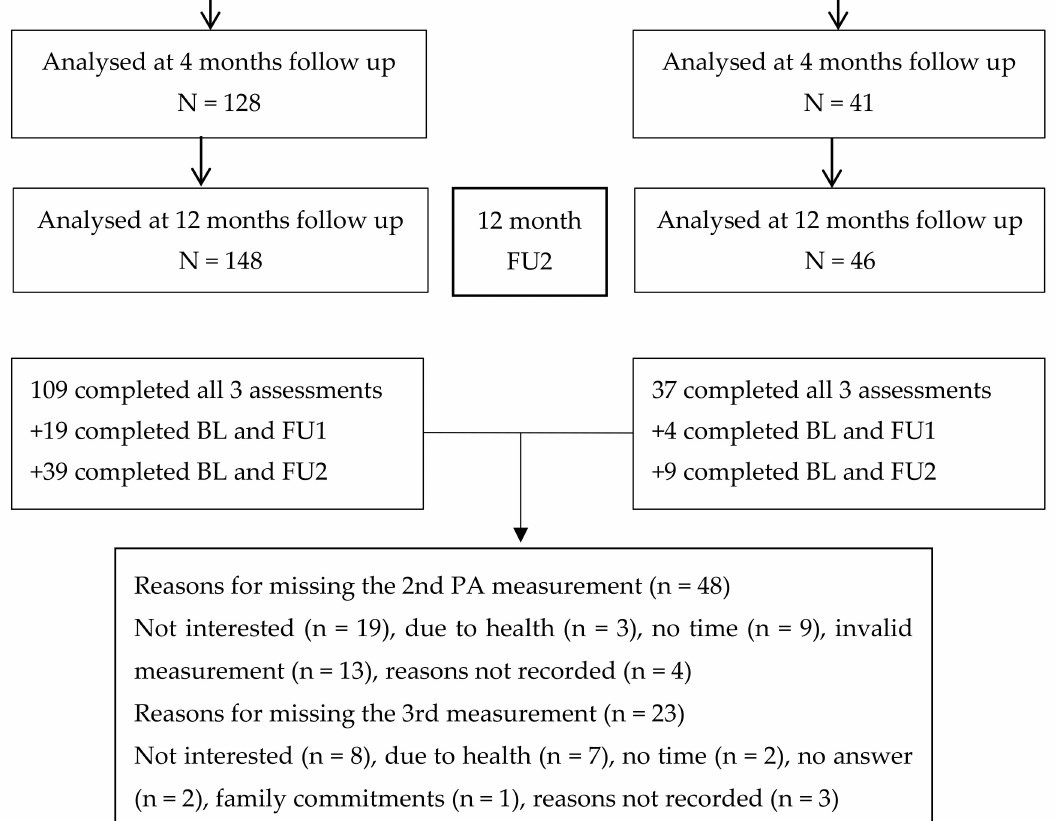
Figure 1. Recruitment and participation flow in the study (BL = baseline, FU = follow-up, N =